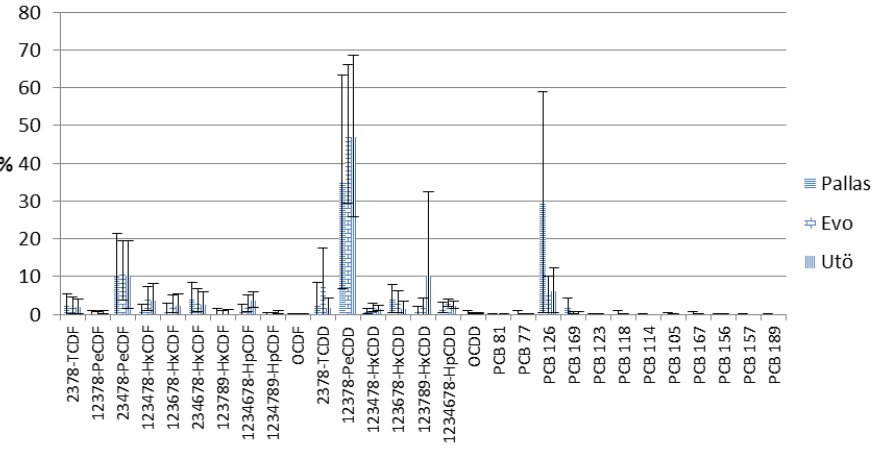
Figure 4. PCDD/Fs and cPCBs congener contributions pg/L WHO-TEQ calculated as % from the sum of all congeners.